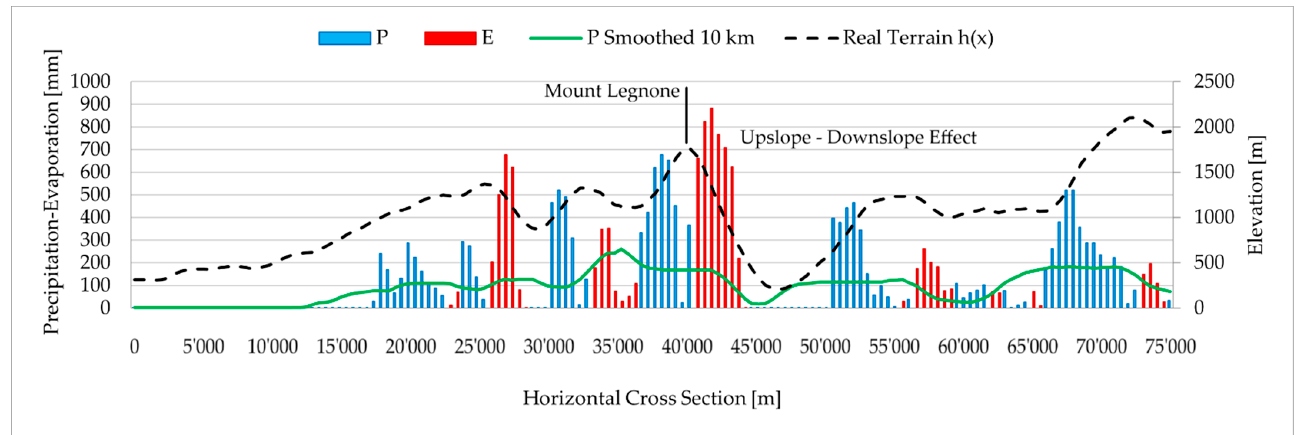
Figure 7. Precipitation P and evaporation E distribution along the south–north cross section. The green line represents the smoothed precipitation field.